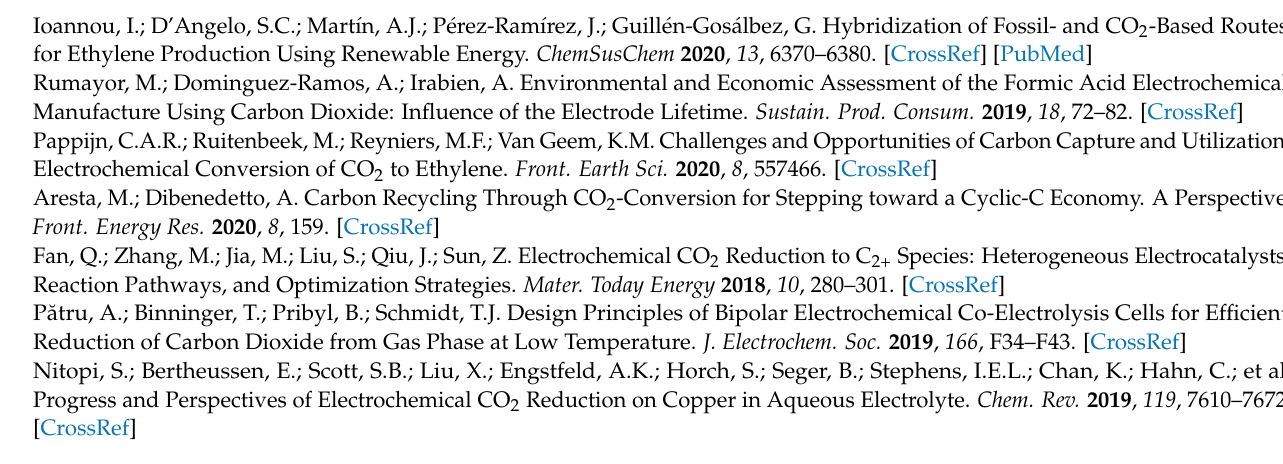
coated electrodes in alkaline media reported previously in literature; Figure S2: process flow di- agram of the CO 2 R experimental setup; Figure S3: cell potential vs. the applied current density applied to the continuous electrochemical reactor using the Fumatech MEA (FAA-3 membrane and Cu:Fumion GDE), the Sustainion MEA (Sustainion membrane and Cu:Sustainion GDE), as schema- tized in Figure 1a. Results obtained with Cu:CS GDE with the Sustainion membrane as the AEM compartment separator are also included for comparison; Figure S4: cell potential vs. the applied current density applied using the MCEs and the Sustainion AEM. Error bars represent the deviation observed for the three experimental measurements along the experiments; Table S4: comparison of the CO 2 conversions with literature values, as a function of current densities and CO 2 flow rates. Unless otherwise stated, the membrane barrier used in our results shown in this table is the Sustain- ion AEM; Figure S5: SEM images of Cu:Fumion GDE (a); Cu:Sustainion GDE (b); Cu:CS GDE (c); CuUZAR-S3CS:PVA/Cu:CS MCE (d); and CuYCS:PVA/Cu:CS MCE (e) after all the experimental runs; Figure S6: Nyquist plots of commercial Cu:Fumion GDE and Cu:Sustainion GDE, measured in Ar at a working electrode potential of − 300 mV in 1 M KOH. The inset shows a zoom of the Nyquist plots at higher frequencies. Measurements were performed in triplicate; Figure S7: Nyquist plots of Toray carbon paper plate and CS:PVA-based membrane coated electrodes (MCE) measured after being saturated in Ar, at a working electrode potential of − 300 mV in 1 M KOH. The inset shows a zoom of the Nyquist plots at higher frequencies. Measurements were performed in triplicate; Figure S8: partial current density of C 2 H 4 achieved with the following MEA configurations: CS:PVA membrane + Cu:CS GDE and CuY@CuUZAR-S3/CS:PVA + Cu:CS GDE. Error bars represent the standard deviation of the FE towards C 2 H 4 of the measurements during each experimental